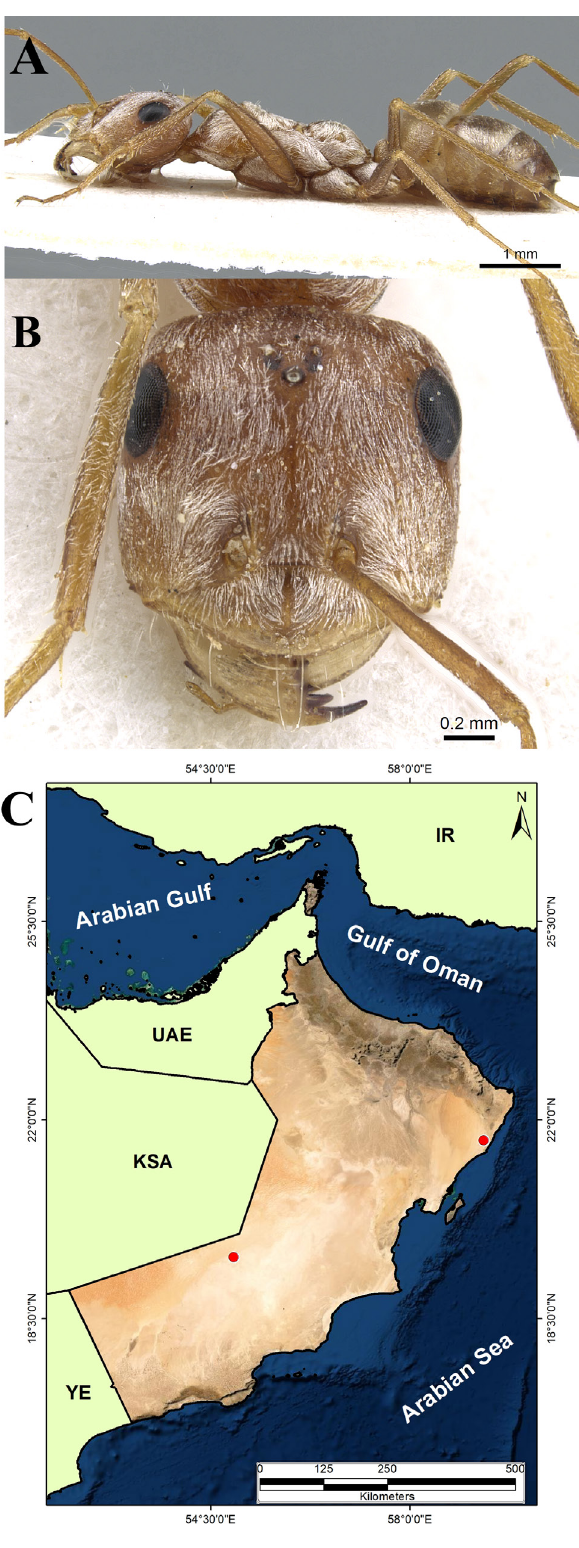
Fig. 13. Cataglyphis sabulosa Kugler, 1981, paratype, worker (CASENT0903289, AntWeb.org (Alexandra Westrich)). A . Body in profile. B . Head in full-face view. C . Distribution